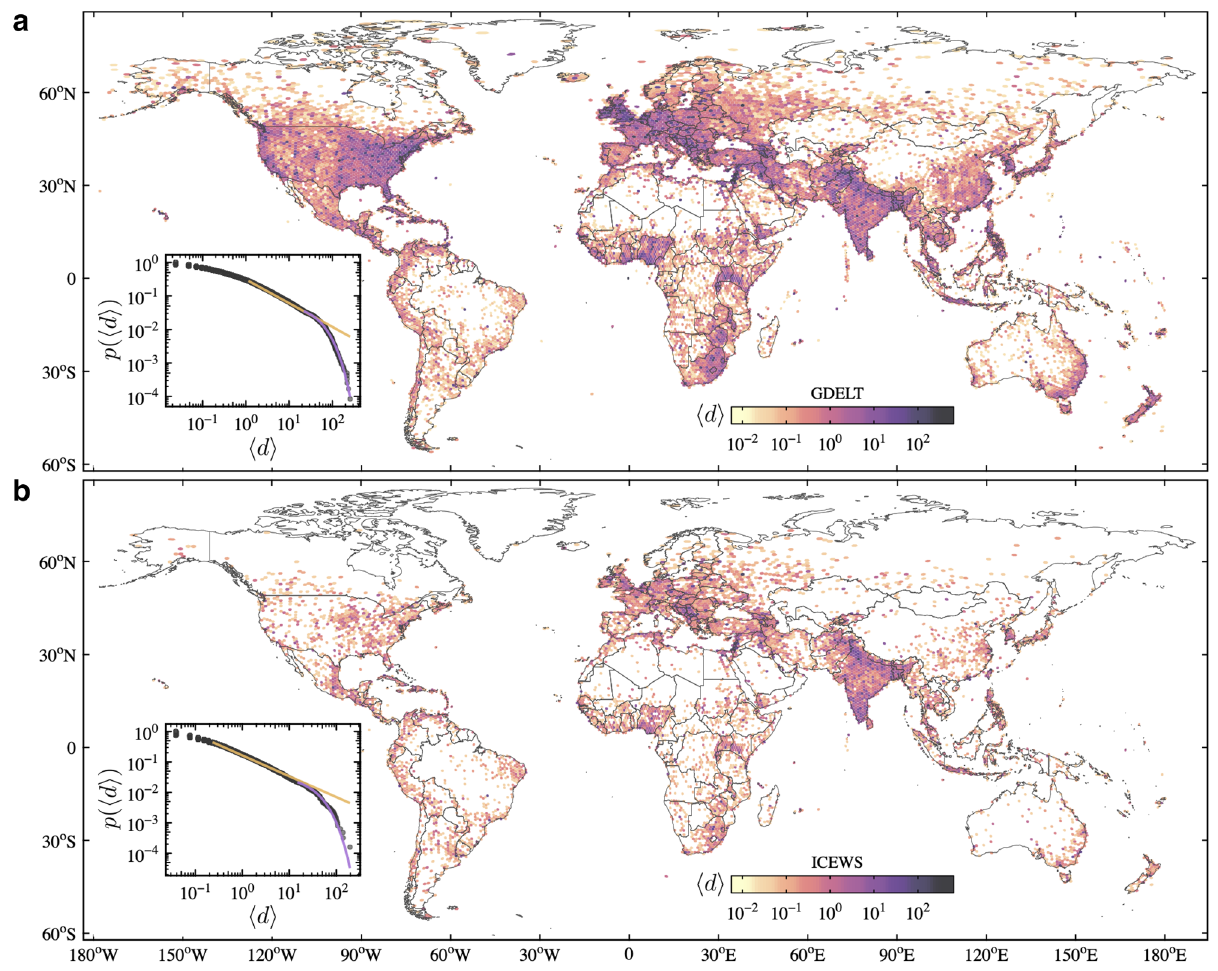
Figure 1. The average number of days with protests by year ( (cid:31) d (cid:30) ) for each cell in the ( a ) GDELT (1979–2020) and ( b ) ICEWS (1995–2020) data sets. The color scale is logarithmic. The inner plots show the probability distribution of (cid:31) d (cid:30) also in a logarithmic scale. The orange and purple lines correspond to power-law and exponential fittings, respectively 34 . Maps were generated using R (version 3.6.2) 44 and the ggplot2 (version 3.3.2) 45